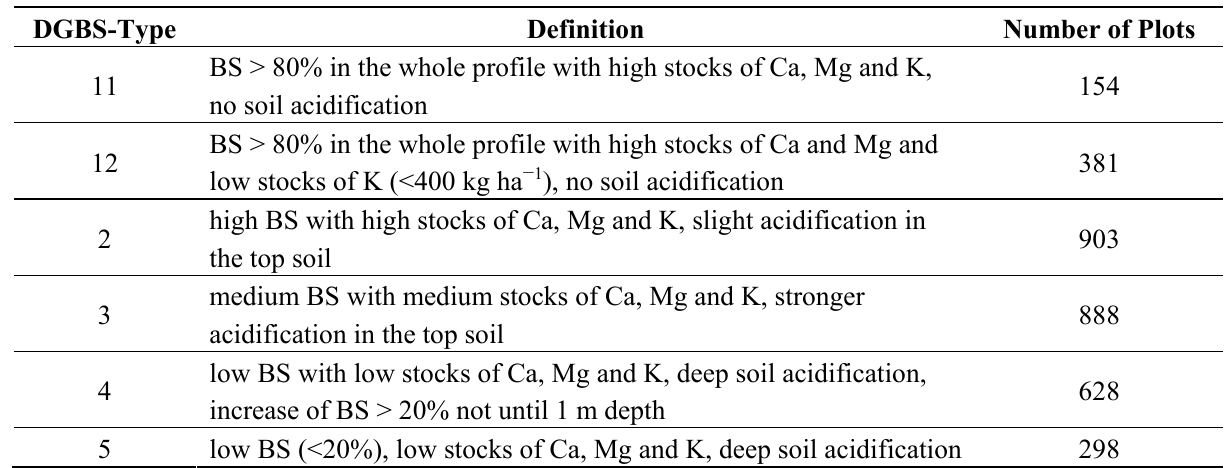
Table 3. Definition of depth gradient of base saturation and number of spruce plots for each